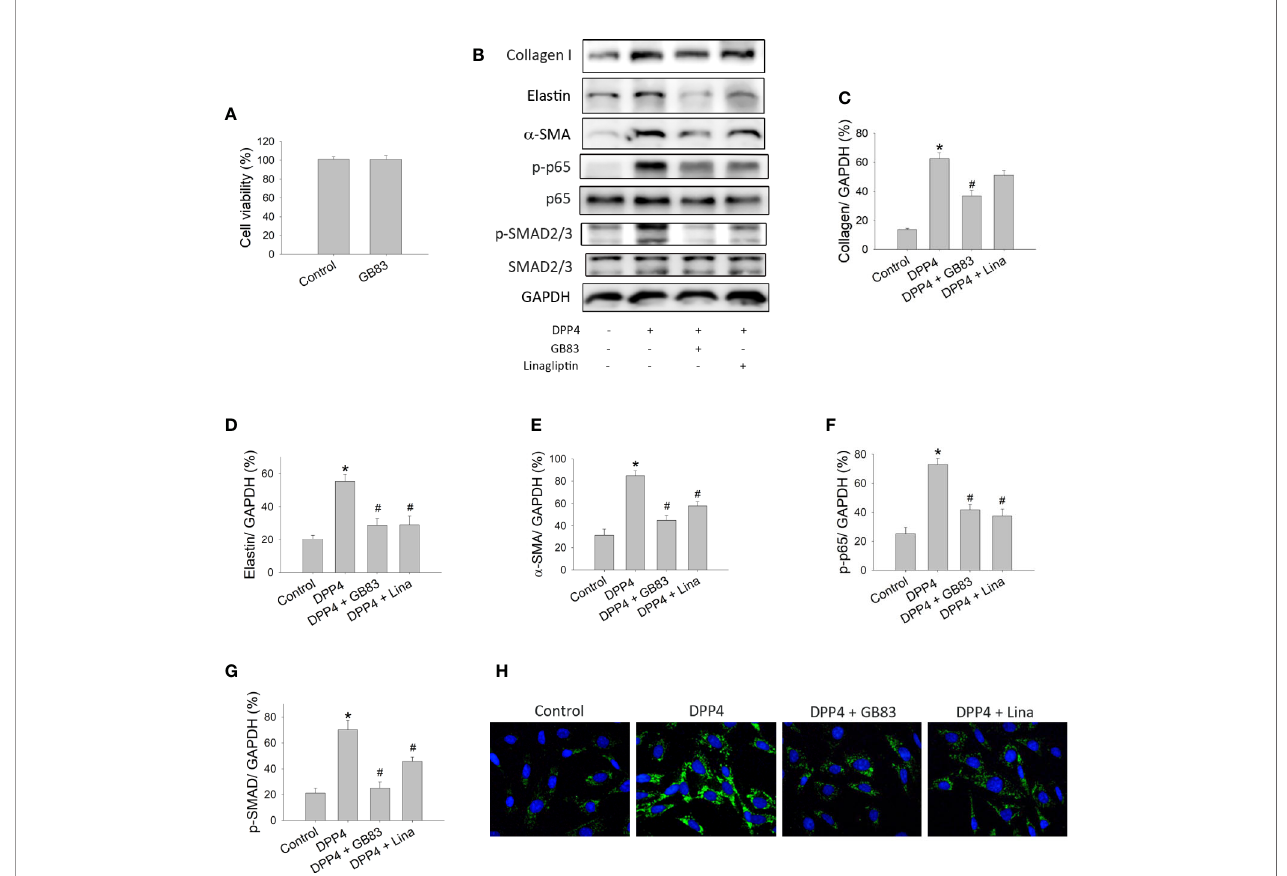
FIGURE 4 | Effects of PAR2 antagonist or DPP4 inhibition on the activation of fi broblasts. Cell viability and protein expression measured in NIH-3T3 fi broblasts after their treatment with recombinant DPP4 (200 ng/ml) in the presence or absence of GB83 (10 µM) or linagliptin (30 nM). (A) Cell viability of fi broblasts exposed to GB83. (B) Protein expression determined using Western blotting. Calculated ratios of (C) collagen I to GAPDH, (D) elastin to GAPDH, (E) a -SMA to GAPDH, (F) NF- k B p-p65 to GAPDH, and (G) p-SMAD2/3 to GAPDH were shown. (n=4) (H) Immuno fl uorescent staining of a -SMA. * p <0.05 vs. control. # p <0.05 vs.